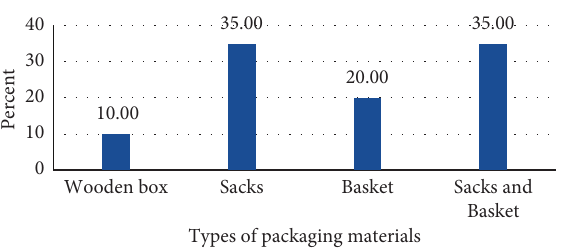
Figure 2: Packaging materials used for fruits and vegetables, n � 40.